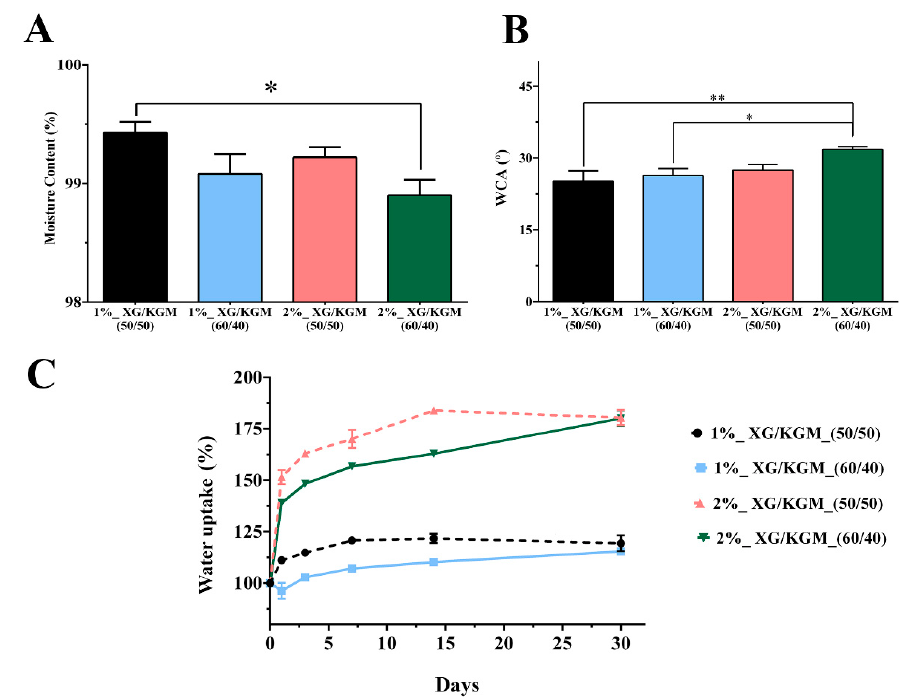
Figure 4. Physicochemical characterization of the hydrogels’ properties. ( A ) Moisture content. ( B ) Water contact angle (WCA). ( C ) Water uptake assay. *, ** Significant differences between groups. The data are shown as means ± standard deviations (n = 3).